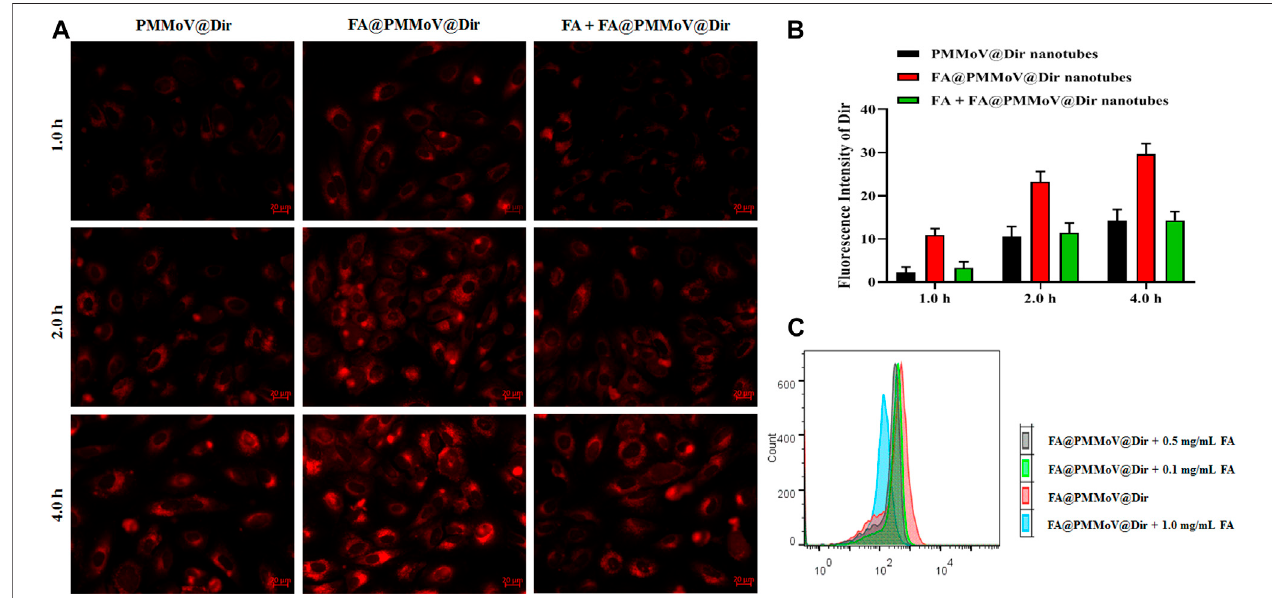
FIGURE 3 | Uptake of FA@PMMoV nanotubes by tumor cells. (A) Images showing the fl uorescence of FA@PMMoV@Dir nanotubes in MCF-7 cells, using PMMoV@Dir nanotubes as control and free FA as receptor competitor. (B) The semi-quantitative fl uorescence signals from (A) . (C) The fl uorescence intensity of FA@ PMMoV@Dir nanotubes in MCF-7 cells treated with different concentrations of free FA (0.1, 0.5, and 1.0